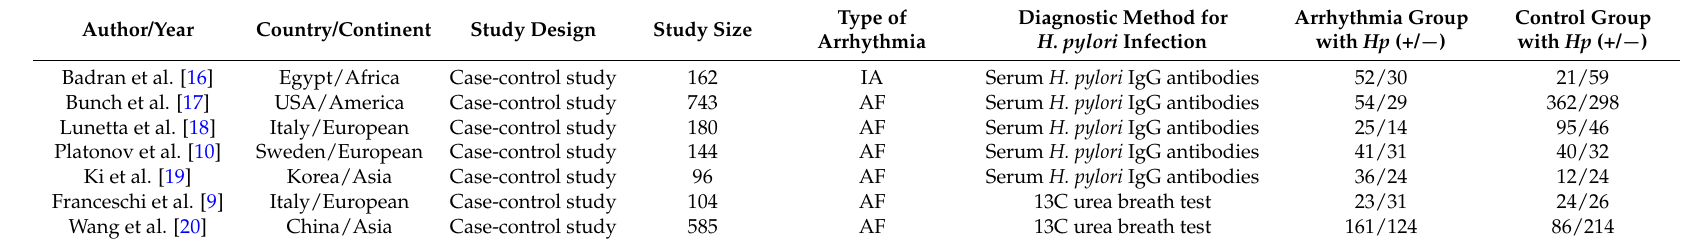
Table 1. Details of included studies reporting the association of Helicobacter pylori infection and arrhythmia.